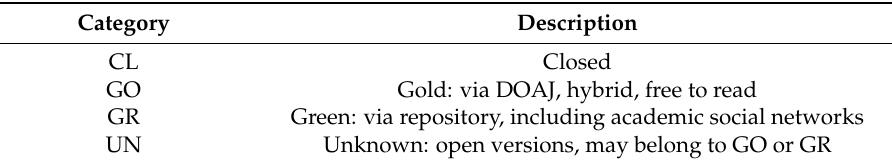
Table 3. 1findr categories of